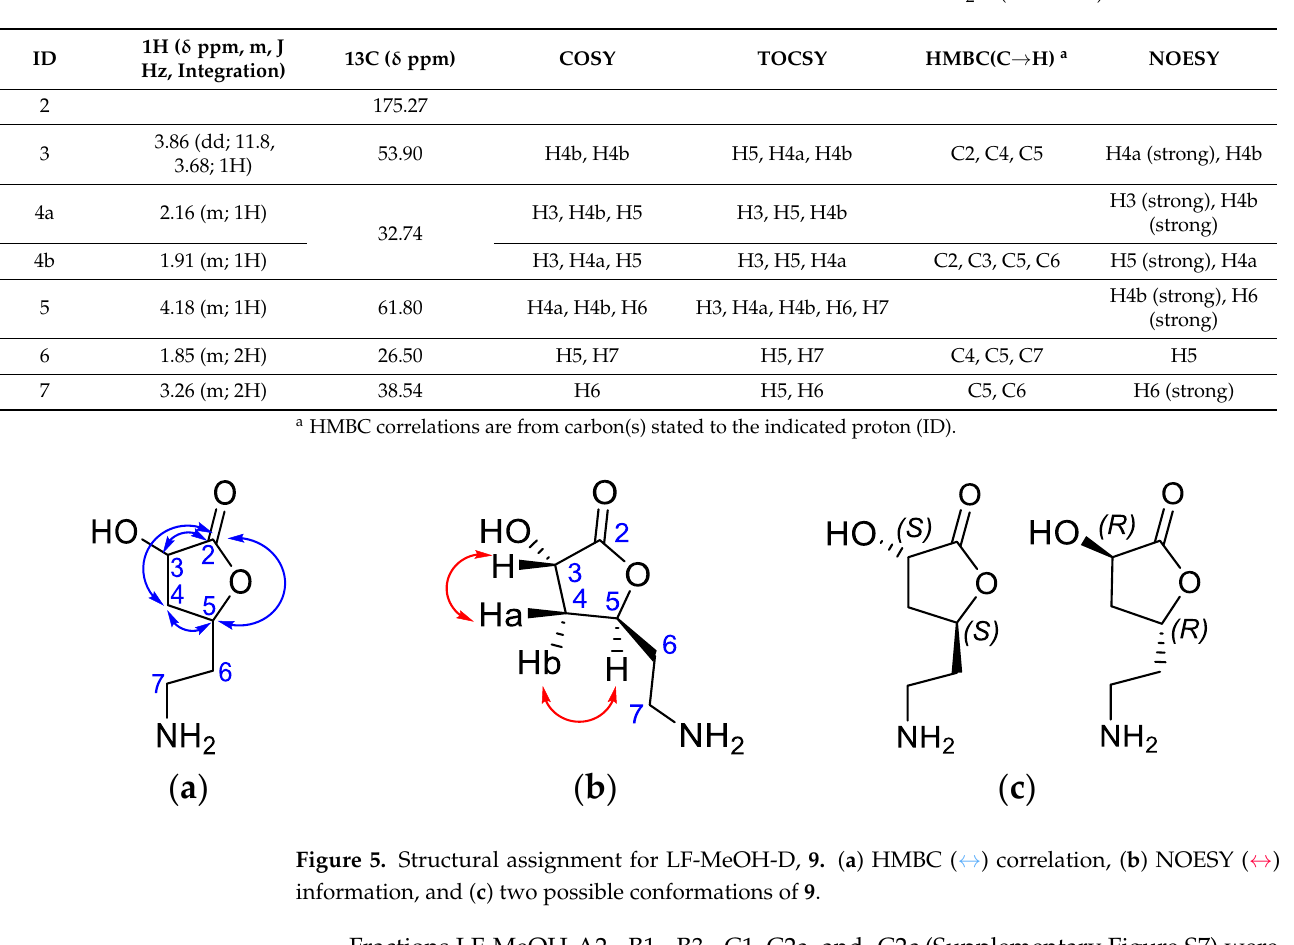
Table 5. The 1- and 2-D NMR data of isolate from LF-MeOH-D in D 2 O (400 MHz).